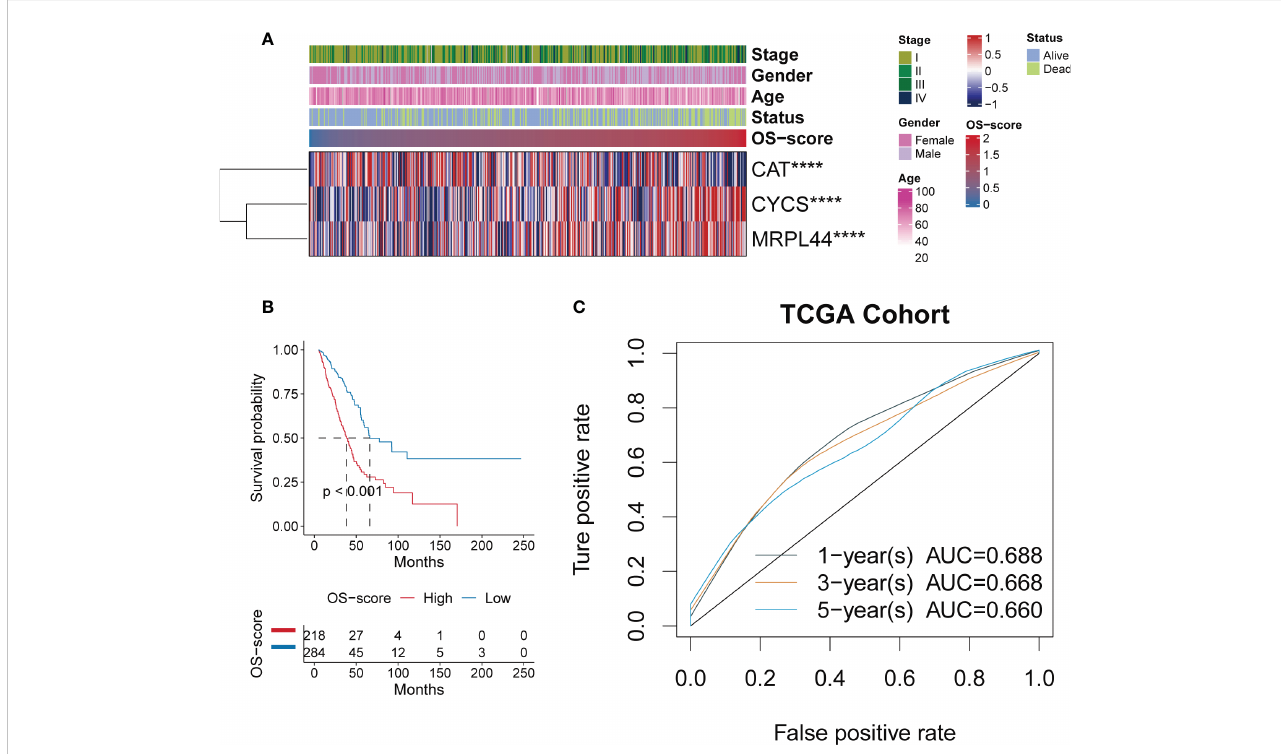
FIGURE 2 Evaluating the ef fi cacy of OS-signature in TCGA for LUAD. (A) The heatmap displaying the distribution of the three oxidative stress related genes (CAT, CYCS, and MRPL44) in the OS-signature, clinicopathological characteristics (Stage, Gender, Age, Survival Status), and OS-score. Red represents high gene expression and blue represents low gene expression. (B) Kaplan-Meier curves displaying the correlation between the OS-score and LUAD patients. The blue curve represents the patients with lower OS-score, and the red curve represents patients with higher OS-score. (C) The 1-year (0.688), 3-year (0.668), 5-year (0.660) survival ROC curves predicted by the OS-signature. Different colored curves represent different years. ****p<0.0001.